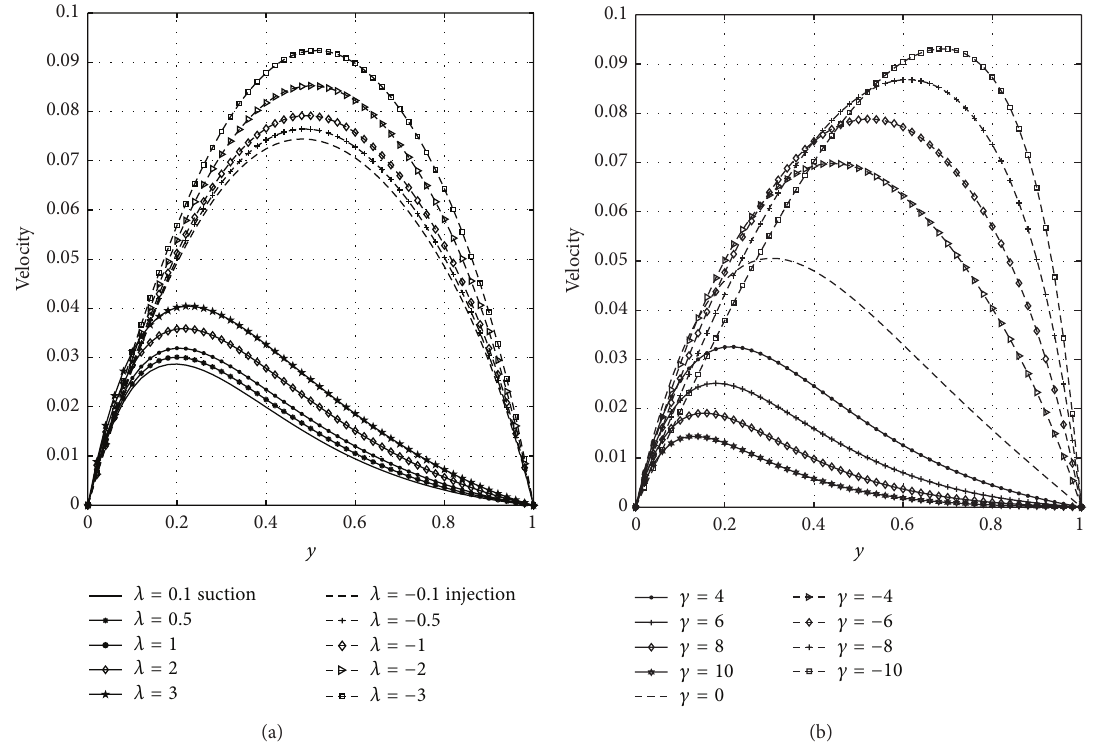
Figure 4: Effects of Frank-Kamenetskii parameter ( 𝜆 ) and suction/injection ( 𝛾 ) on